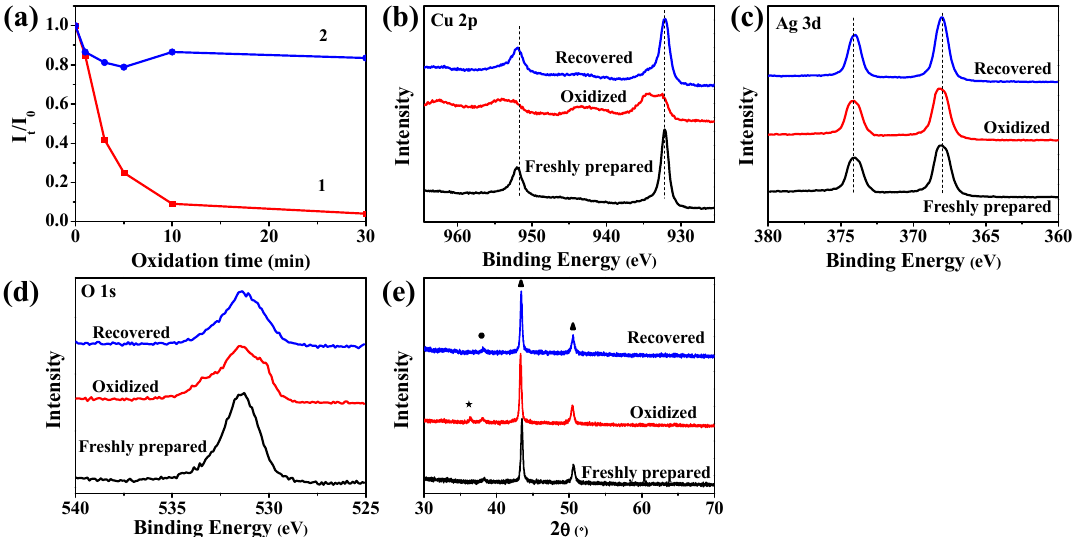
Figure 6. Recovering of the oxidized Cu-Ag SERS chip. ( a ) Dependence of the relative SERS intensity (I t /I 0 ) of the Cu-Ag chip on oxidation time (curve 1) and the recovered value after a vacuum drying treatment of the oxidized chip (curve 2). ( b – d ) XPS spectra of the freshly prepared, oxidized and recovered Cu-Ag chips: ( b ) Cu 2p, ( c ) Ag 3d, and ( d ) O 1s envelops. ( e ) XRD patterns of the freshly prepared, oxidized and recovered Cu-Ag chips.